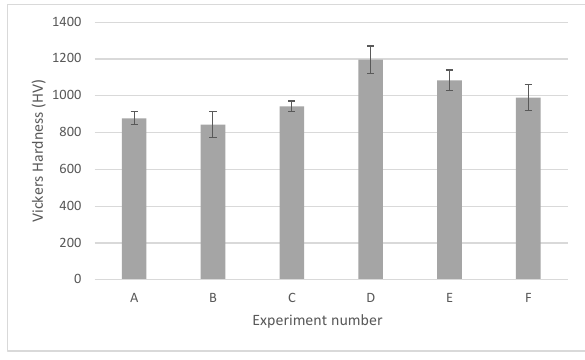
Figure 8: Variation of hardness values in products with different